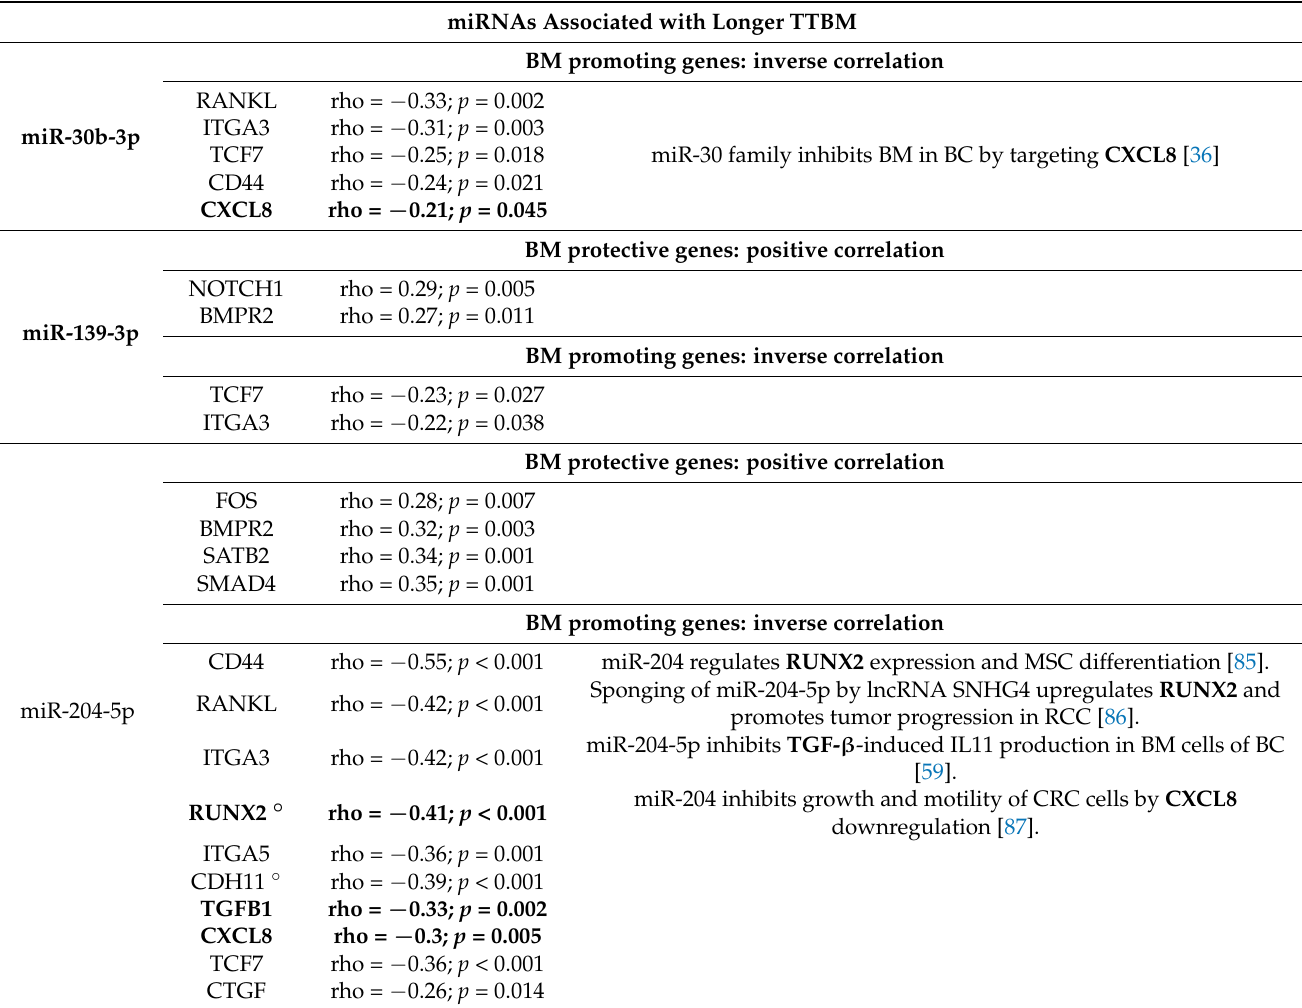
Table 3. Correlations of miRNA with gene expression (Spearman correlation test, p -value < 0.05). miRNAs Associated with Longer